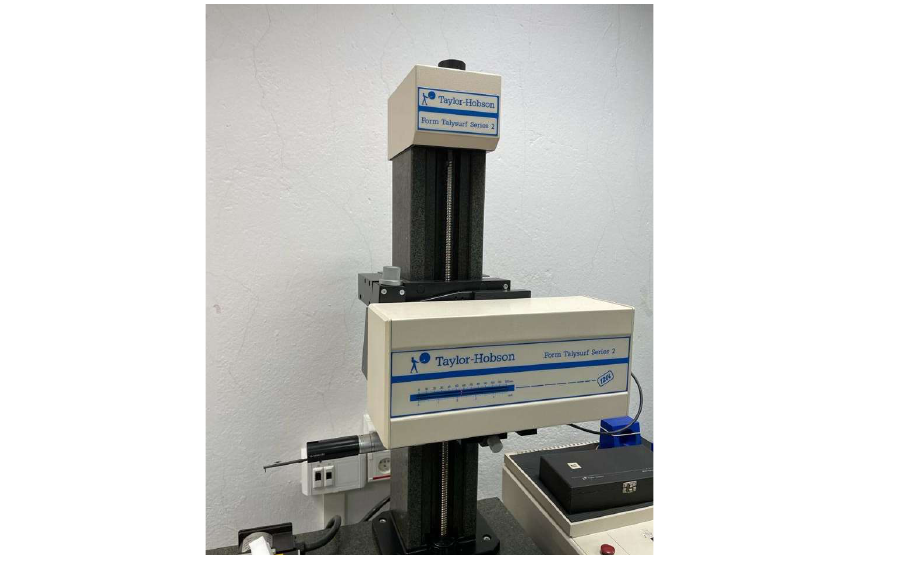
Figure 3. Taylor Hobson Talysurf 2 contact roughness meter. Measurement results obtained in the honing test are presented in Table 2. The results for average roughness (Ra) are not included in this study and will be presented elsewhere. Table 2. Results of the honing tests.